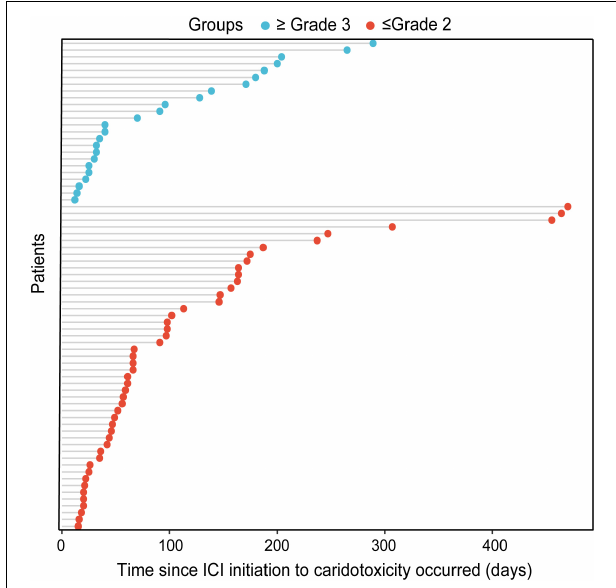
FIGURE 2 | Bubble chart of the time since ICI initiation to the occurrence of mild cardiotoxicity and severe cardiotoxicity.